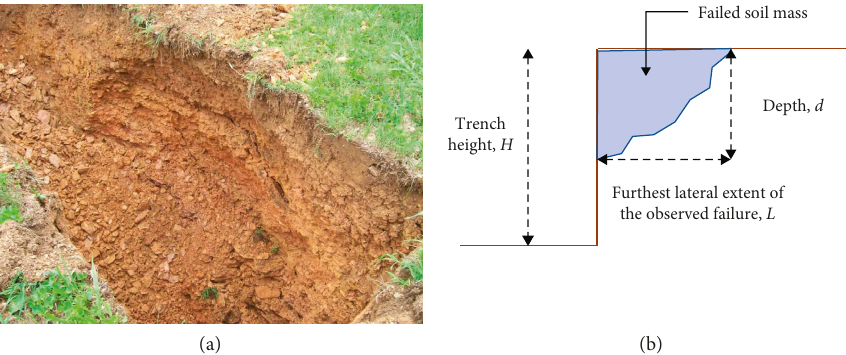
Figure 1: (a) Typical trench failure profile for Type C soil: (a) observed in situ with weak lenses and soil heterogeneity; (b) profile of failure shape with failure extents for derivation of the T-L